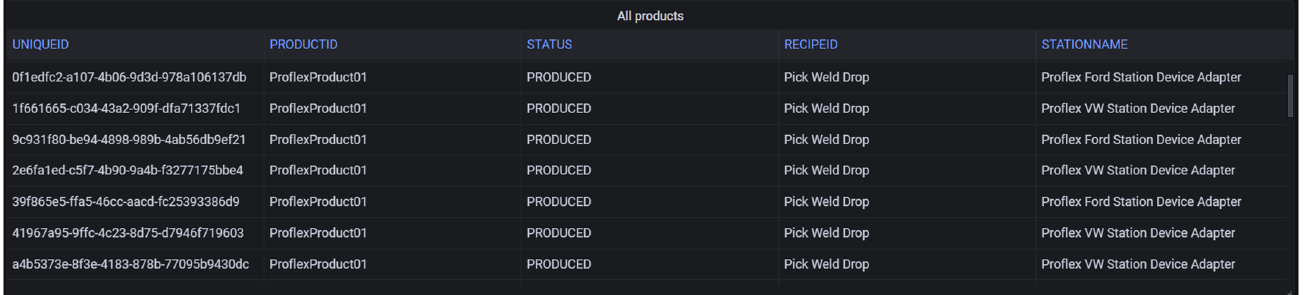
Figure 19. Products panel.